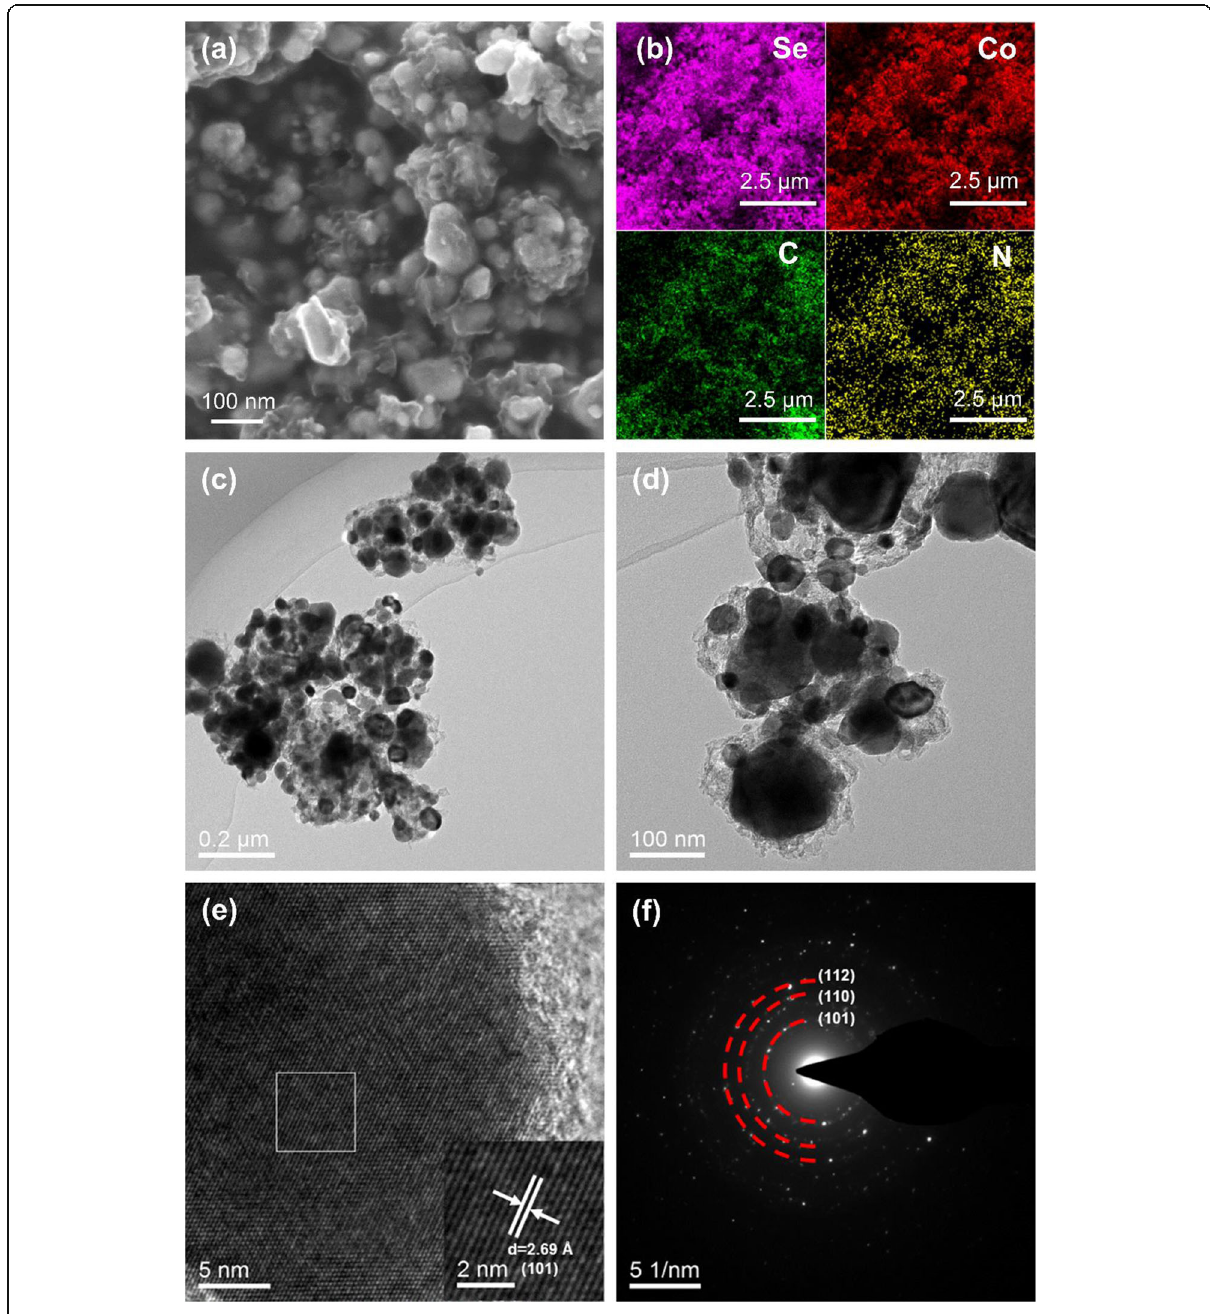
Fig. 5 a SEM image of CoSe/NC. b Elemental mapping images of CoSe/NC. c , d TEM images of CoSe/NC. e HRTEM images of CoSe/NC. f SAED pattern of